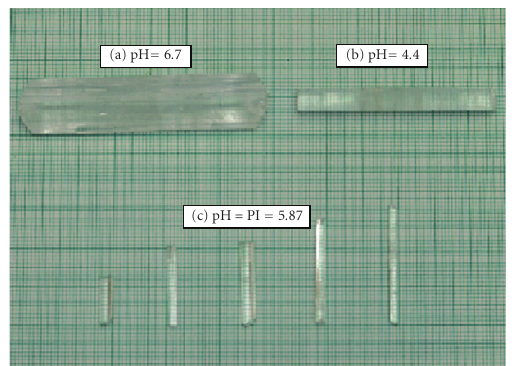
Figure 12: Photograph of L-threonine crystal grown at di ff erent pH.